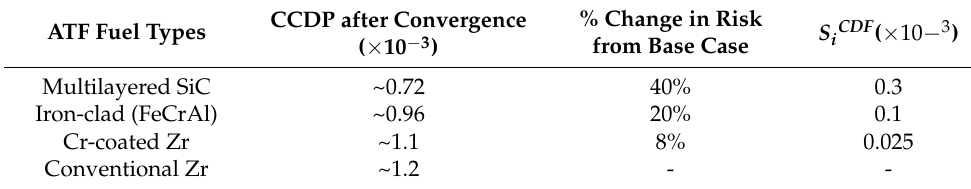
Figure 12. Conditional core damage probability profile for ATF fuel types: ( a ) Multi-layered SiC; ( b ) Iron-clad (FeCrAl); ( c ) Chromium-coated Zircaloy (Cr-coated Zr). Table 6. Benefit index for ATF candidates.